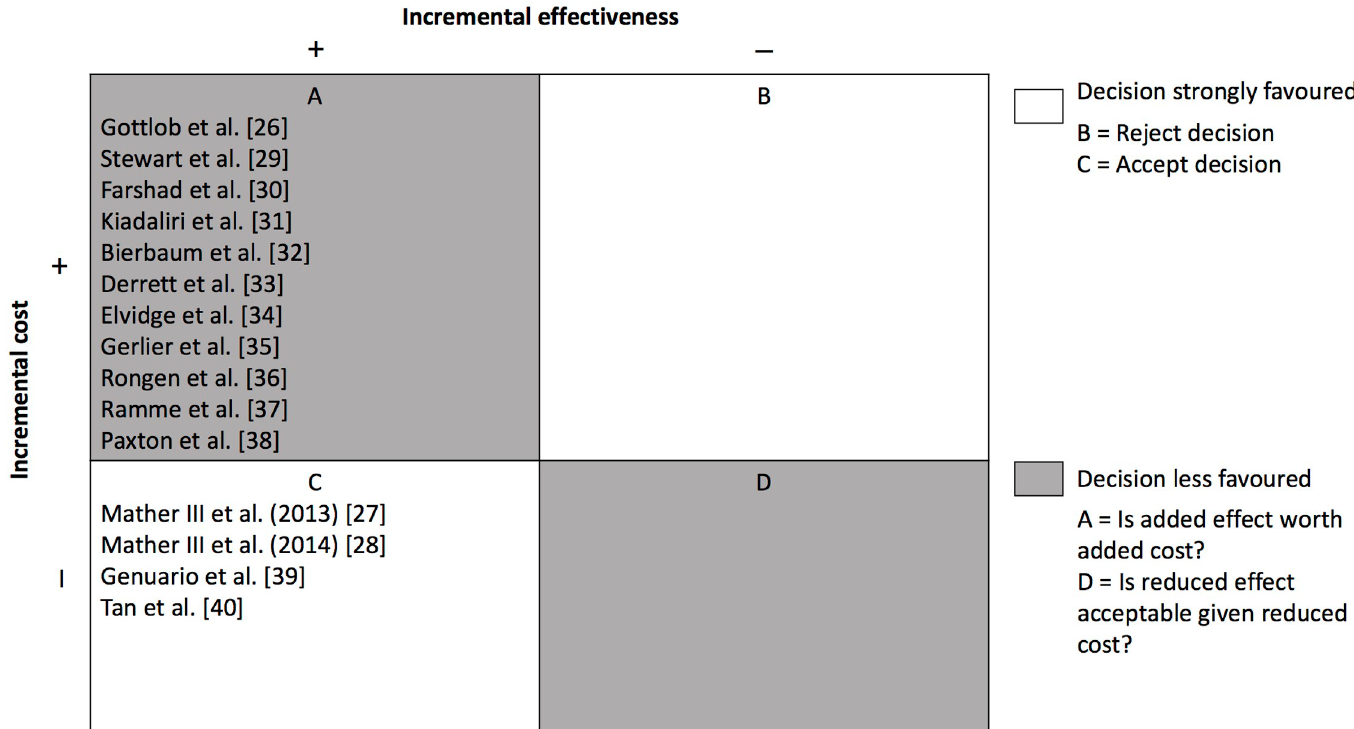
Fig 2. Permutation matrix for possible outcomes of economic evaluations for studies of interventions vs comparator. The letters indicate if the intervention should be accepted, rejected or there is no obvious decision to make. The shading offers a means of more easily identifying the implications for decision making.